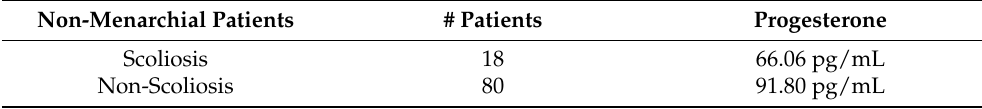
Table 3. Progesterone values for non-cycling patients. Non-Menarchial Patients # Patients Progesterone Scoliosis 18 66.06 pg/mL Non-Scoliosis 80 91.80